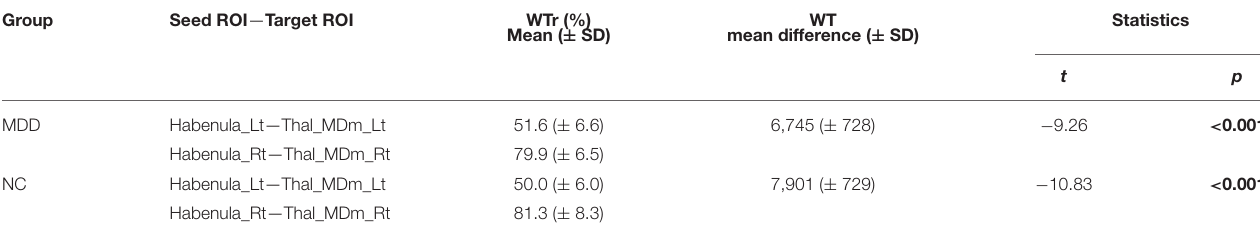
TABLE 3 | The interhemispheric difference of the waytotal of the tracts from the habenula to the mediodorsal thalamus.